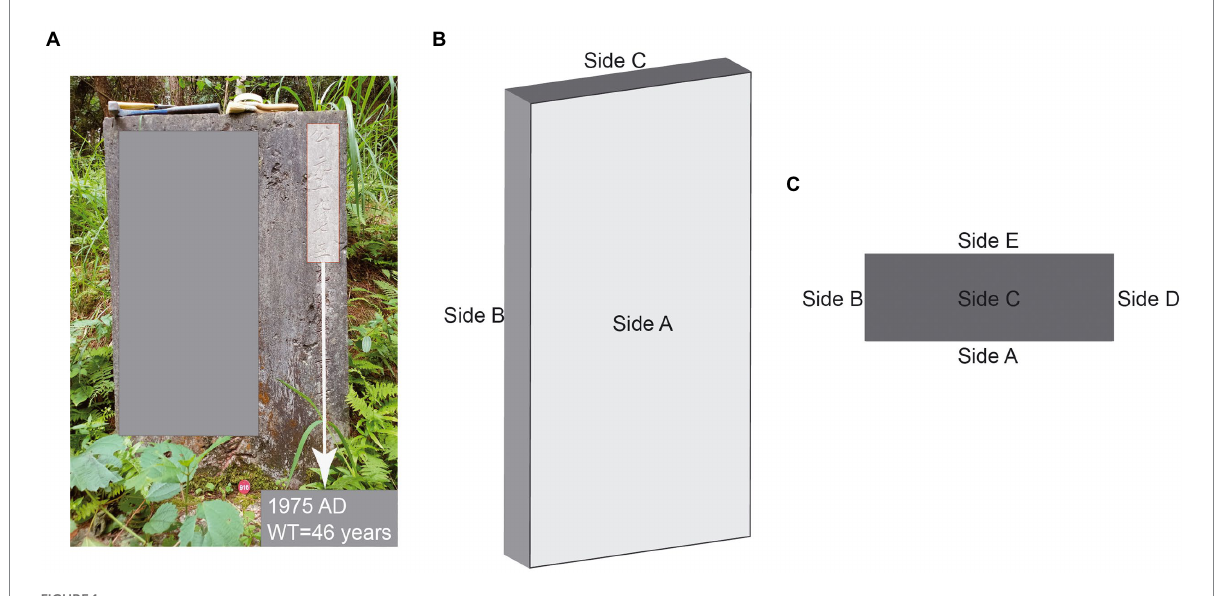
FIGURE 1 Sketch of carbonatite tombstone; (A) Entity diagram of carbonatite tombstone, (B) Stereogram of carbonatite gravestone, (C) Top view of carbonatite